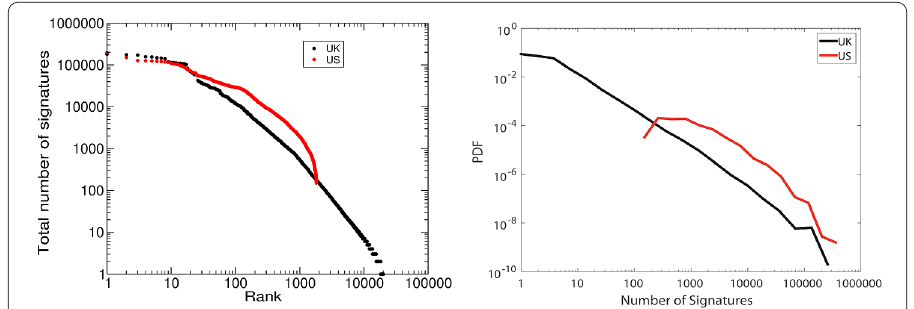
Figure 2 Distribution of the number of signatures to petitions. Left: The total number of signatures per petitions is plotted against the rank order of the petition based on its total number of signatures. Note that the petitions appear on the US website only if they are already signed 100 times. Right: Probability Distribution Function (PDF) of the number of signatures to the